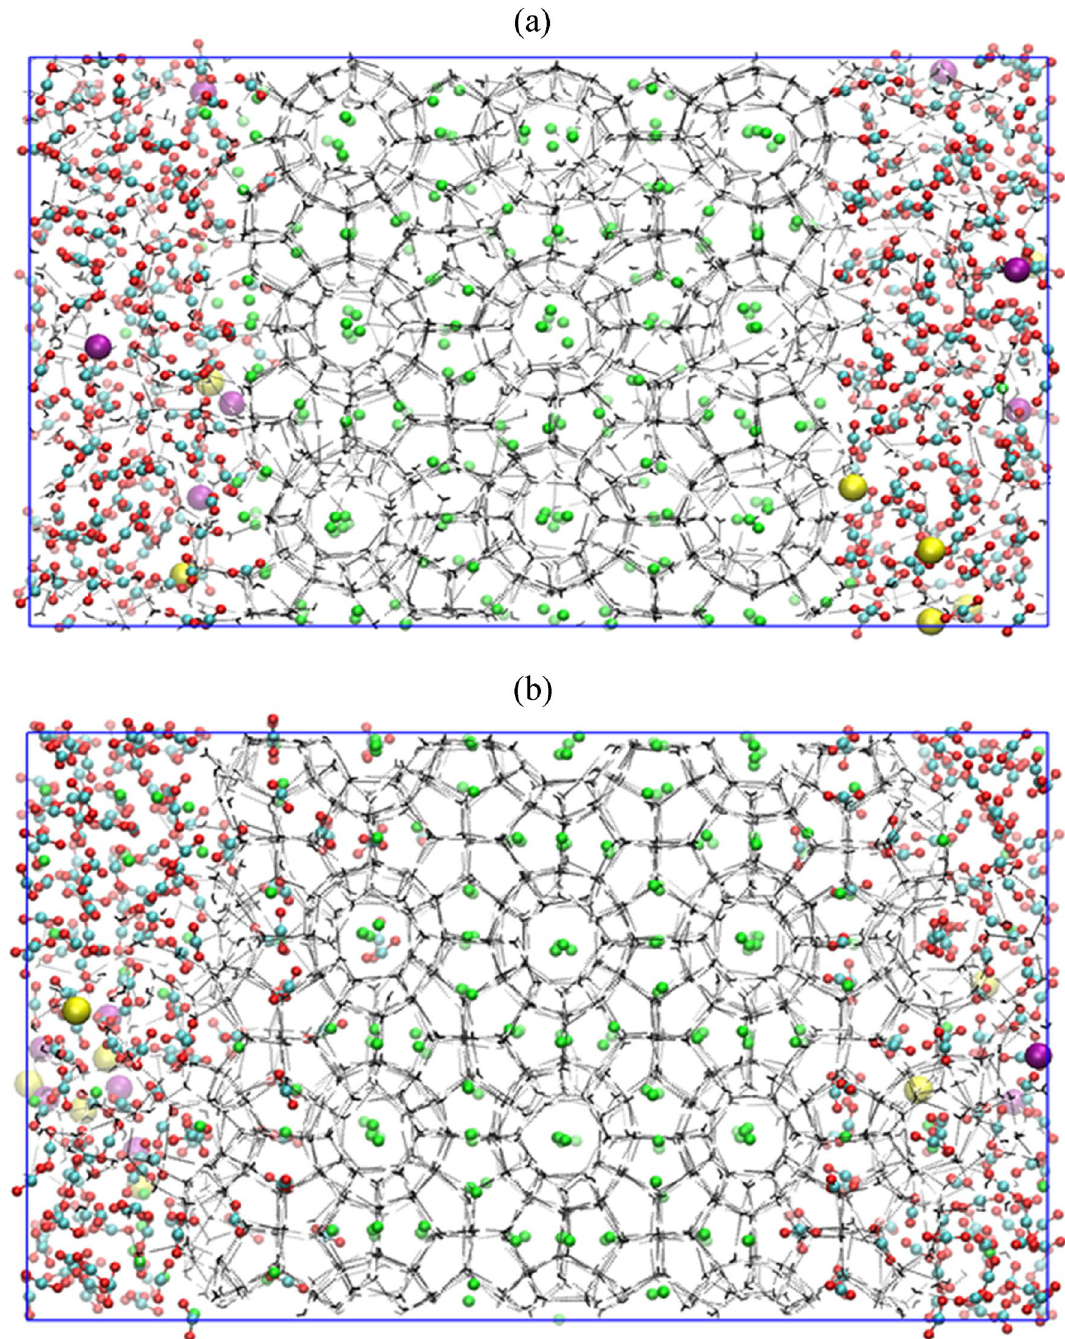
Figure 6. Screenshot of the CH 4 –CO 2 replacement dynamics in presence of free water molecules, carbon dioxide and salt ions with operating conditions of 260 K and 50 MPa at ( a ) 0 µs and ( b ) 2 µs. The atoms of sodium and chlorine ions are represented by purple and yellow spheres, respectively. The water molecules are defined by TIP4P-Ew